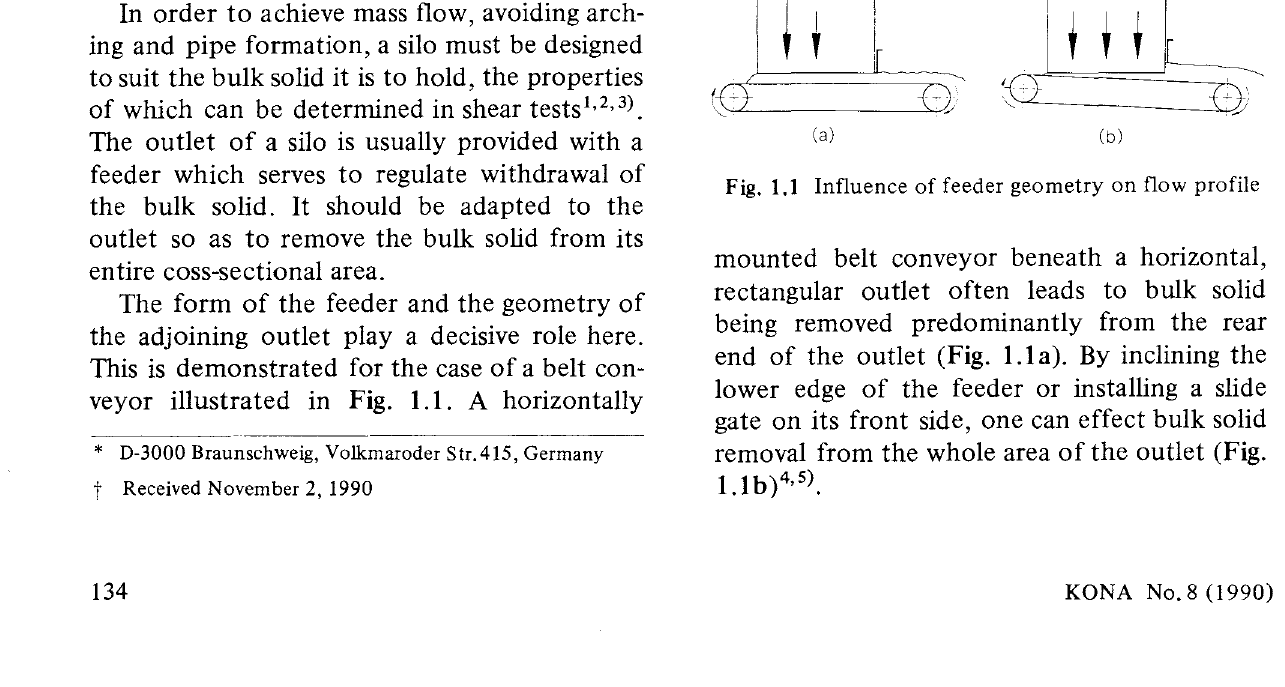
Fig. 1.1 Influence of feeder geometry on flow profile mounted belt conveyor beneath a horizontal, rectangular outlet often leads to bulk solid being removed predominantly from the rear end of the outlet (Fig. 1.1 a). By inclining the lower edge of the feeder or installing a slide gate on its front side, one can effect bulk solid removal from the whole area of the outlet (Fig. 1.1 b